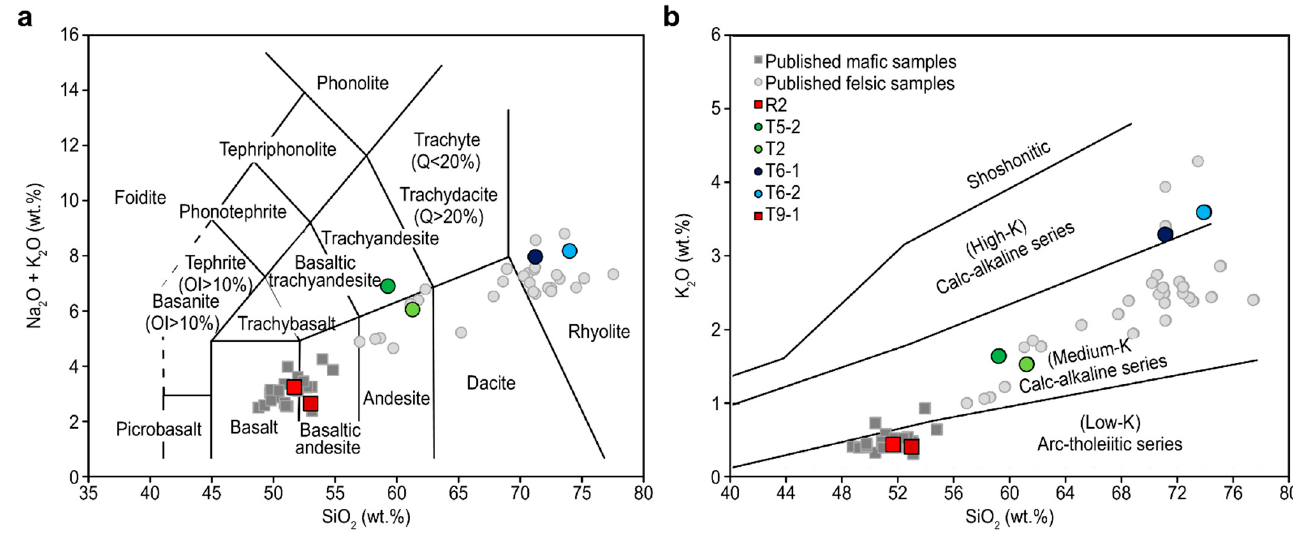
Figure 3. Classification diagrams for the MOT and SOT volcanic lavas. ( a ) Plots of Na 2 O + K 2 O vs. SiO 2 . The base diagram is from [87], and the boundary between the alkaline and subalkaline rocks is from [86]. ( b ) K 2 O (wt.%) vs. SiO 2 (wt.%). Boundaries are from [88]. Data for published mafic samples are from [1,36,50,74]. Data for published felsic samples from [1,73,74]. Data for samples R2, T5-2, T6-1, T2, T6-2, and T9-1 are from this study.